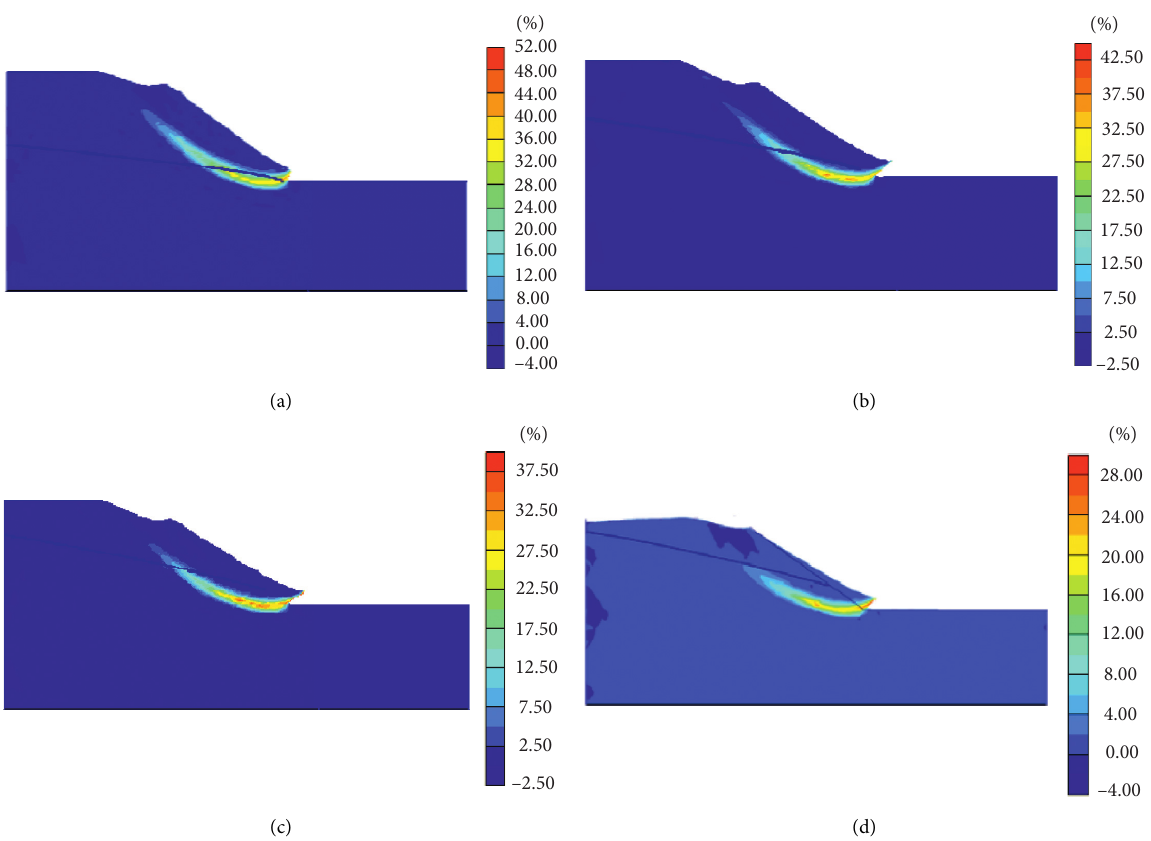
Figure 7: Analysis model of the slope. (a) Groundwater level 10m (grade IV). (b) Groundwater level 15m (grade III). (c) Groundwater level 20m (grade II). (d) Groundwater level 25m (grade